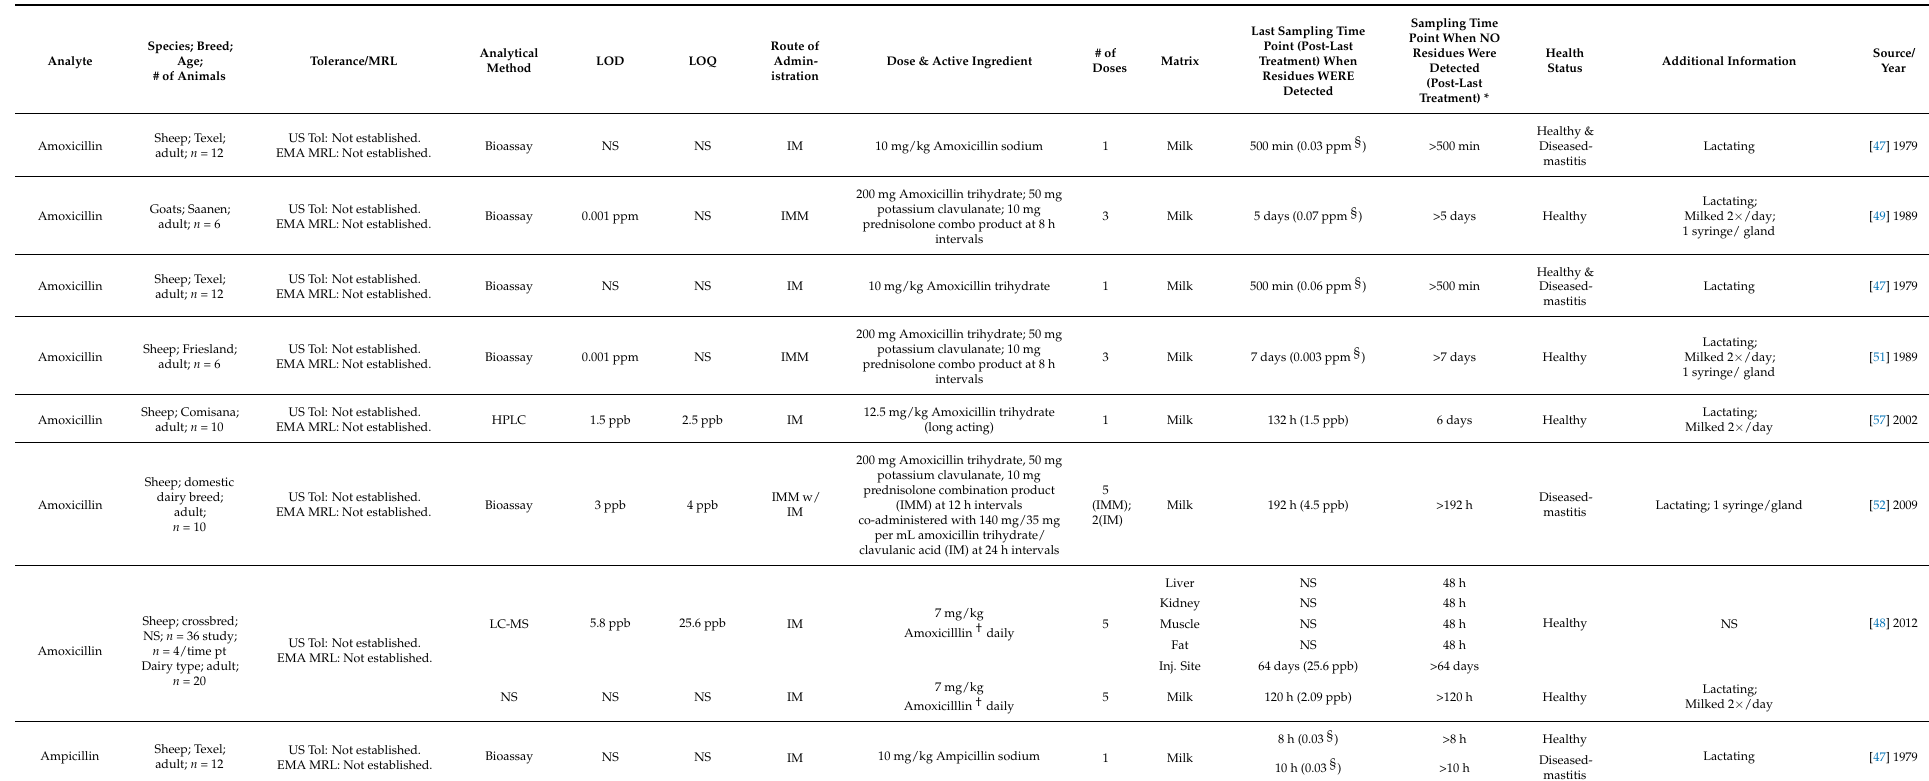
Table 3. Penicillin and penicillin-derivative residues in milk or edible tissue samples from sheep or goats following treatment.